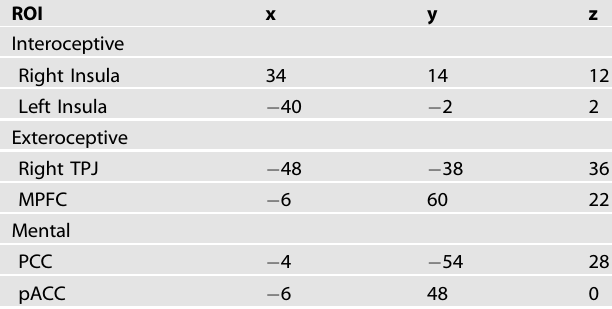
Pearson correlation ’ s rho ( ρ ) value between the BOLD signal within voxel/ ROI ( x ) and averaged BOLD signal within gray matter mask ( y ) (See eq. 1) [38]. Global Signal Topography is Z GSCORR value for each voxel/ROI that measures the contribution of each voxel/region to global brain activity. We calculated GSCORR for each of the three layers of Self. ROI selection for layers explained in the section below, Global Signal Topograhpy- ROI Selection.